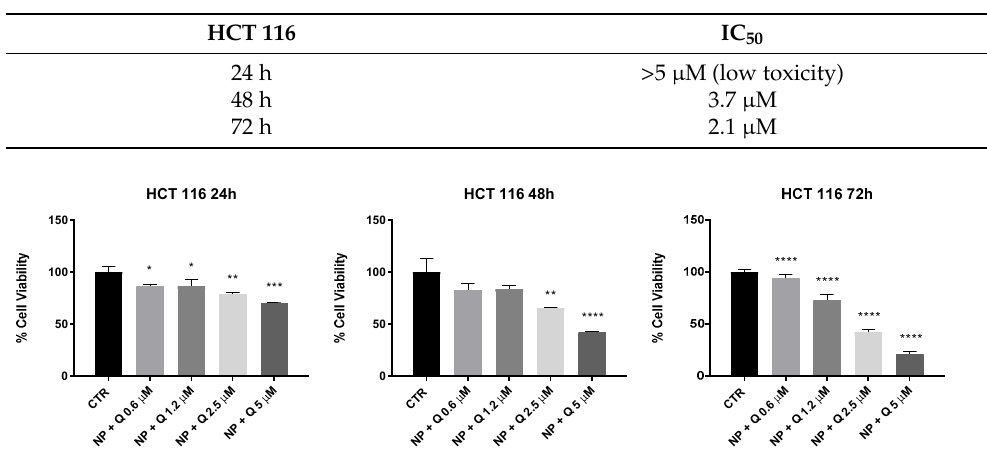
Table 2. IC50 (µM) of quercetin-loaded nanoparticles on HCT 116, after 24 h, 48 h, and 72 h of treat- Table 2. IC50 ( µ M) of quercetin-loaded nanoparticles on HCT 116, after 24 h, 48 h, and 72 h ment. of treatment.